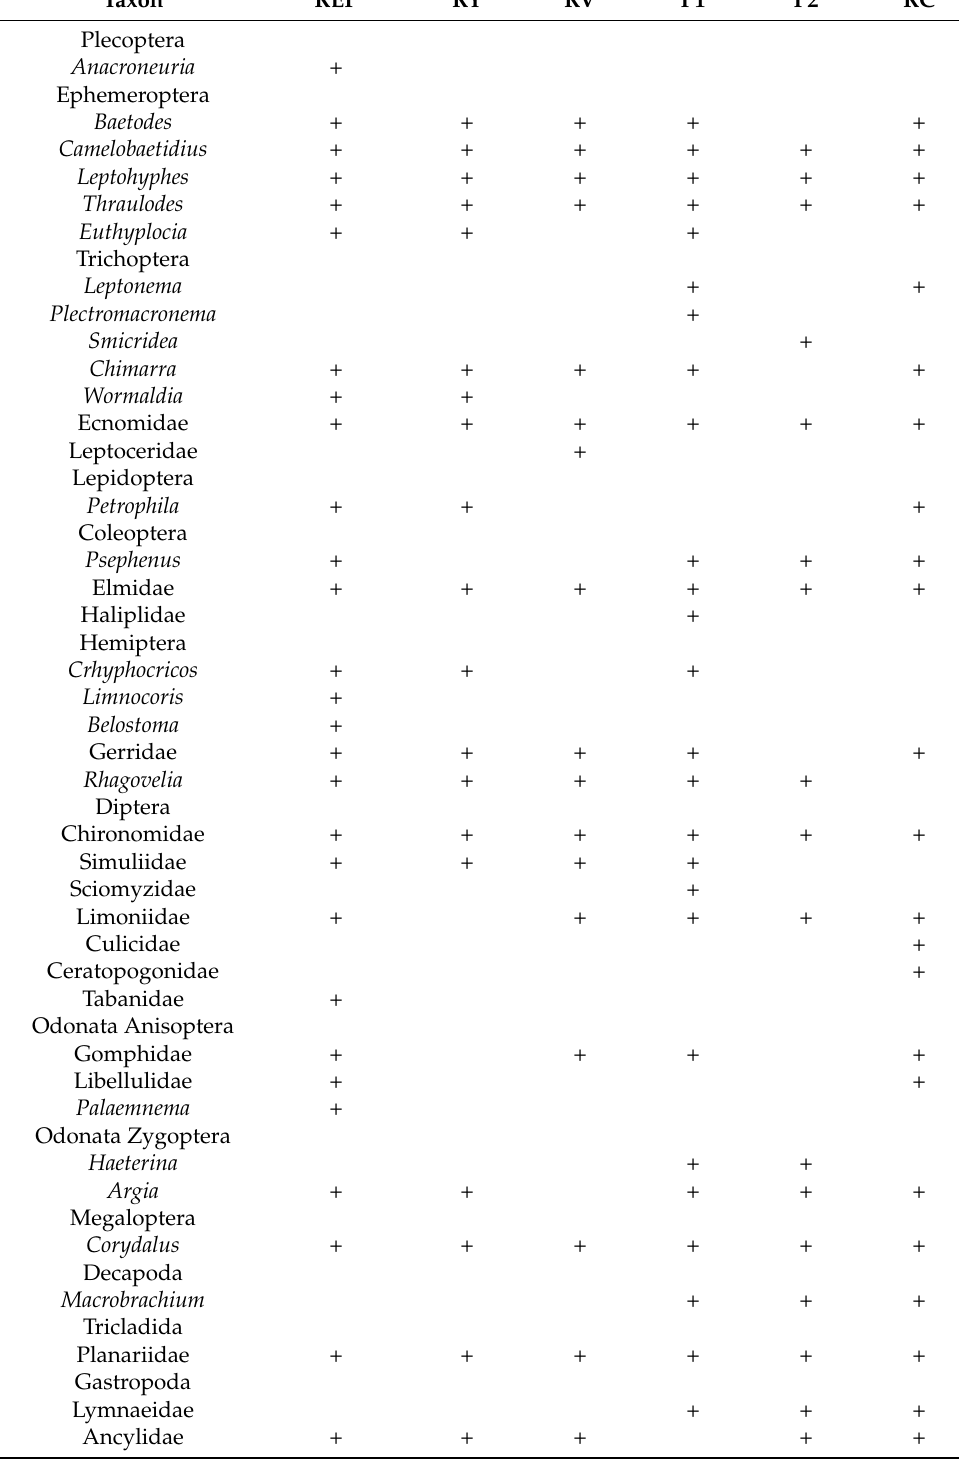
Table 1. Presence/absence of the macroinvertebrate taxa in the six sites (REP = R í o El